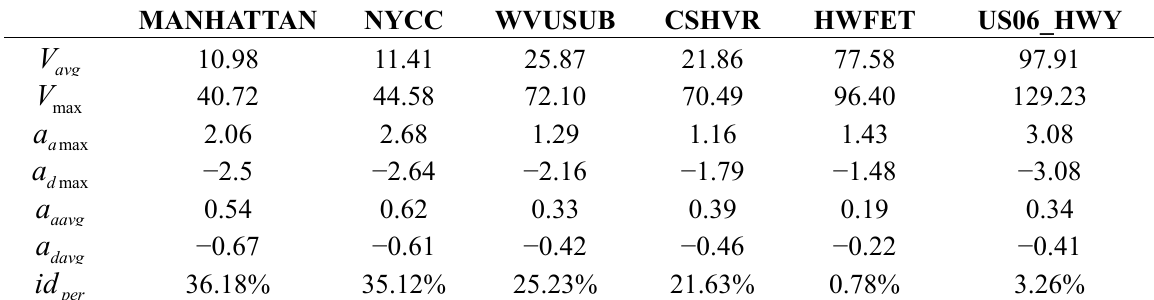
Table 2. Representative features of six standard driving